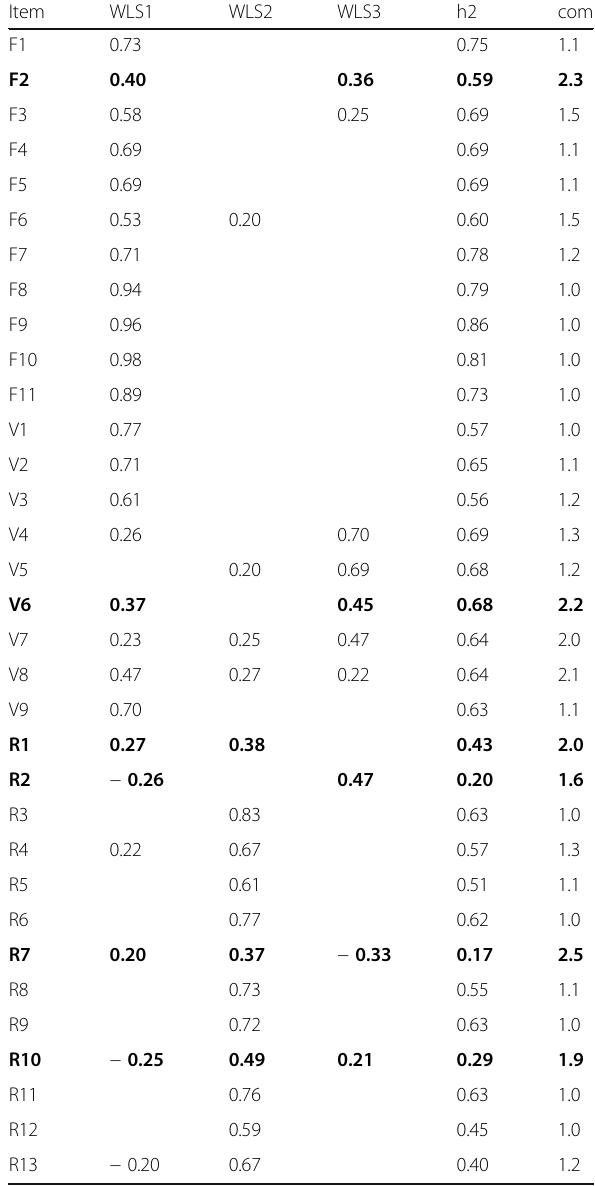
Table 3 Pattern matrix from the 3-factor solution for first round of EFA with all original items. Bold font indicates items with low pattern coefficients on the focal factor or high pattern coefficients on a second